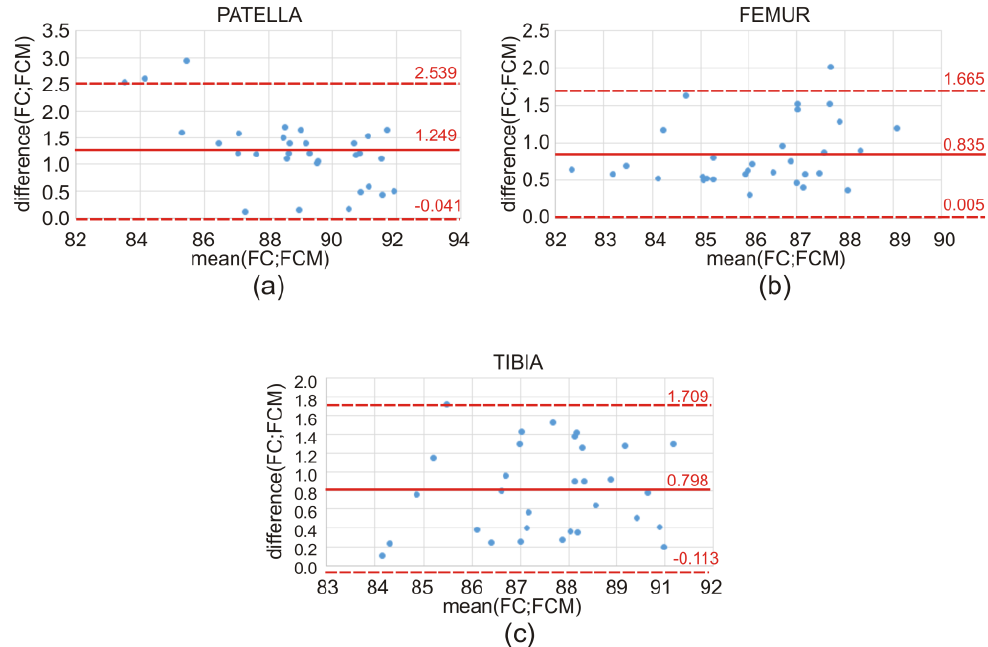
Figure 8. Discrepancy in the obtained values of the Dice index between the FC and FCM methods for CT studies of the lower limb on the transverse plane, illustrated using Bland–Altman plots, for the ( a ) patella, ( b ) femur, and ( c ) tibia, respectively.